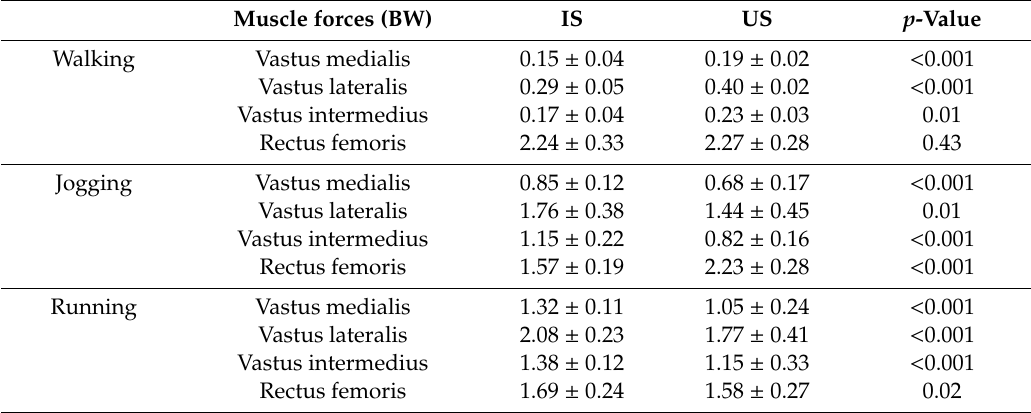
Table 4. The peak quadriceps femoris muscle forces of the involved side (IS) and the uninvolved side (US) during walking, jogging and running movements, BW equals body